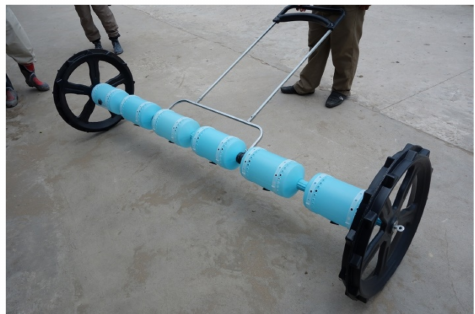
Figure 9. Drum seeder for rice seed sowing. Source: Photo was taken by the author at An Giang province on 5 September